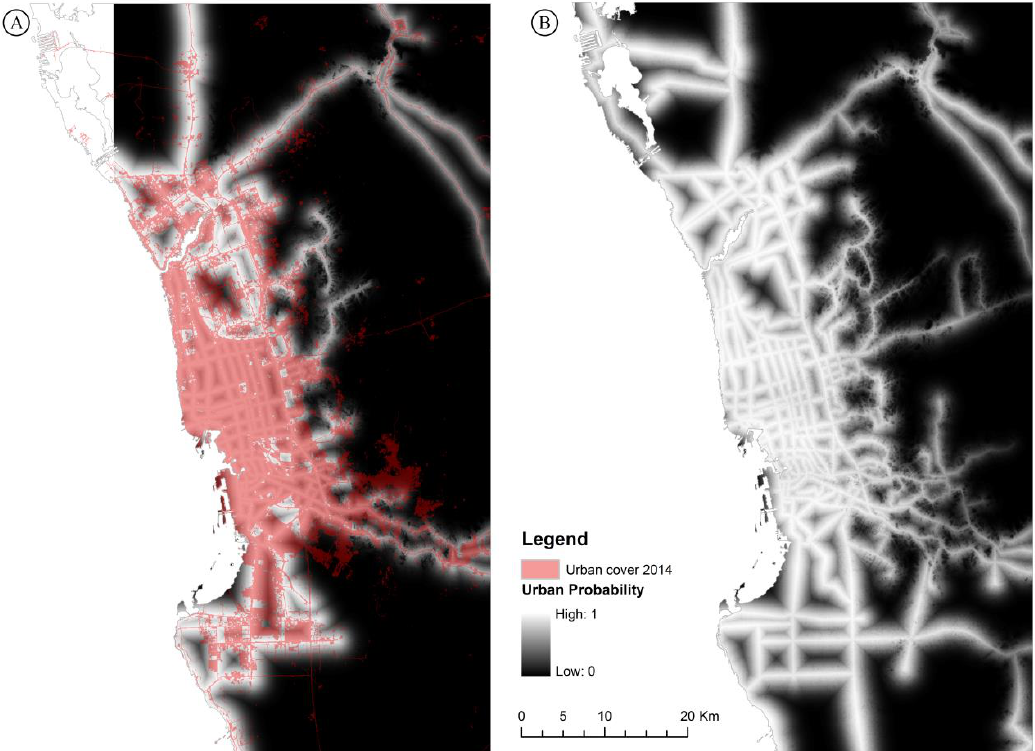
Figure 6. Urbanization probability maps in Jeddah ( A ) a comparison of the urban probability in 1985 and urban areas in 2014; ( B ) urban probability in 2014.